Question: What style of plot is this figure drawn as?
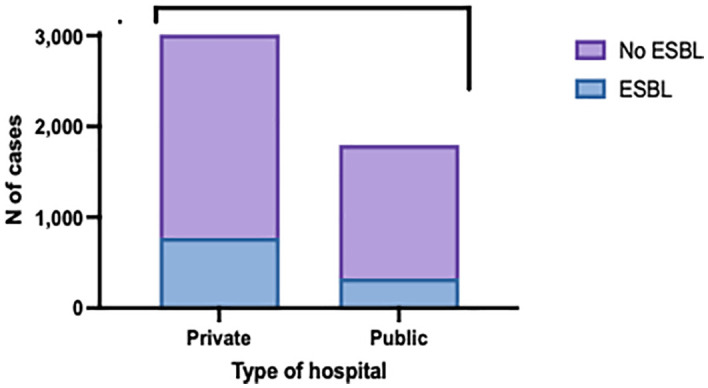
Answer: bar